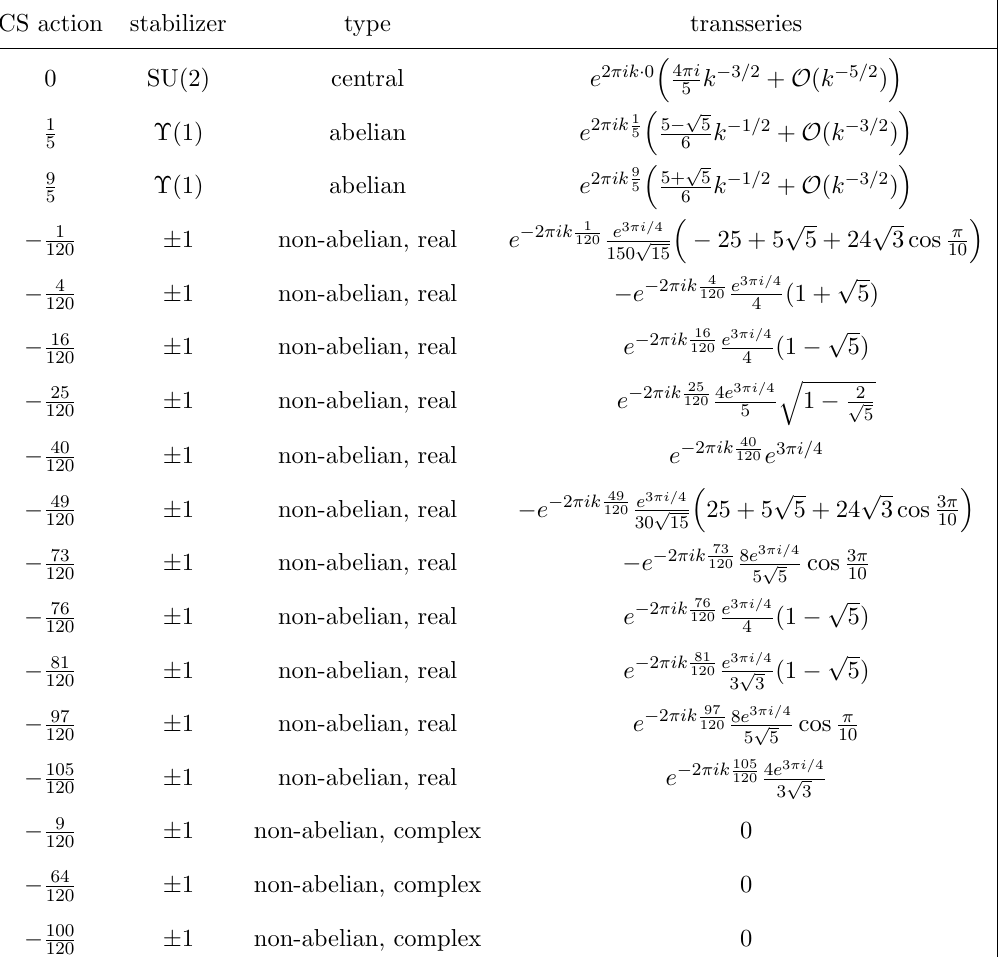
Table 15 . Transseries and classi(cid:12)cation of (cid:13)at connections on M (